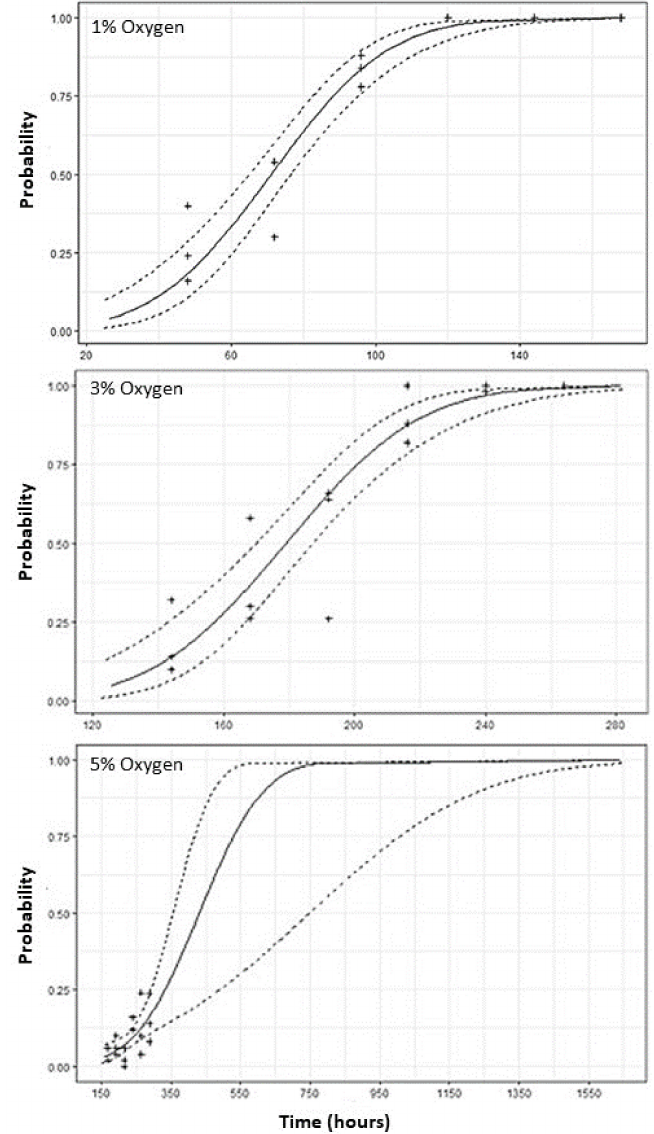
Figure 1. The probability of the mortality of S. oryzae with respect to time (hours) at 1, 3, and 5% oxygen levels. The dotted line represents the upper and lower level of 95% confidence interval of regression